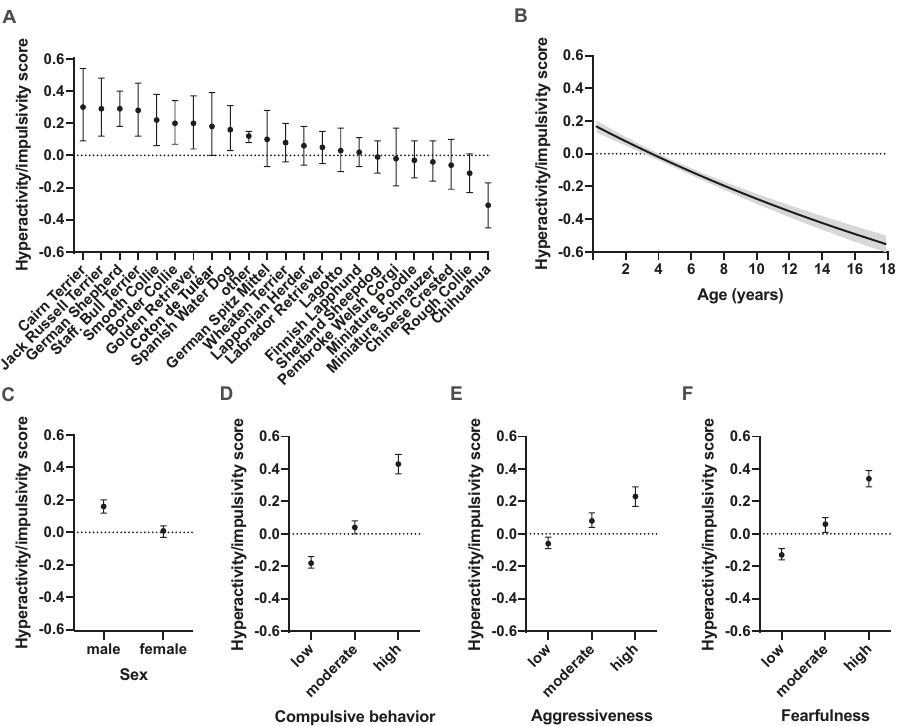
Fig. 1 Canine hyperactivity/impulsivity. The effects of breed ( A ), age ( B ), sex ( C ), compulsive behaviour ( D ), aggressiveness ( E ) and fearfulness ( F ) on canine hyperactivity/impulsivity. Grey area ( B ) and error bars ( A , C , D , E , F ) indicate 95% con fi dence limits. N = higher hyperactivity/impulsivity scores than dogs showing low levels of fearfulness (z-ratio = 8.77, df = 1, p = 0.0008). Factors associated with inattention Statistical analysis identi fi ed several demographic, environmental and behavioural factors associated with inattention scores, including breed, age, sex, daily time spent alone, activities/ training, compulsive behaviour, aggressiveness and fearfulness (Table 1). We detected signi fi cant differences in inattention scores between dog breeds. The breeds with the highest scores were Cairn Terrier, Golden Retriever and Finnish Lapponian Dog. The breeds with lowest scores were Spanish Water Dog, Miniature Poodle and Border Collie (Fig. 2A). The largest pairwise differences were found between Border Collie and other (z-ratio = − 8.01, df = 1, p = 0.0005), Border Collie and Finnish Lapponian Dog (z-ratio = − 7.60, df = 1, p = 0.0005), Border Collie and mixed breed (z- ratio = − 6.83, df = 1, p = 0.0005) and Border Collie and Wheaten Terrier (z-ratio = − 6.54, df = 1, p = 0.0005). All pairwise breed differences are presented in the Supplementary Dataset. Age of the dog was associated with inattention (Table 1 and Supplementary Fig. S2A). Inattention scores were highest in young dogs (linear effect: F = 8.73, df = 1, p = 0.0031, quadratic effect: F = 0.56, df = 1, p = 0.561) as we hypothesised a priori. Signi fi cant differences were also found between sexes as males had higher inattention scores than females (z-ratio = 8.95, df = 1, p < 0.0001;